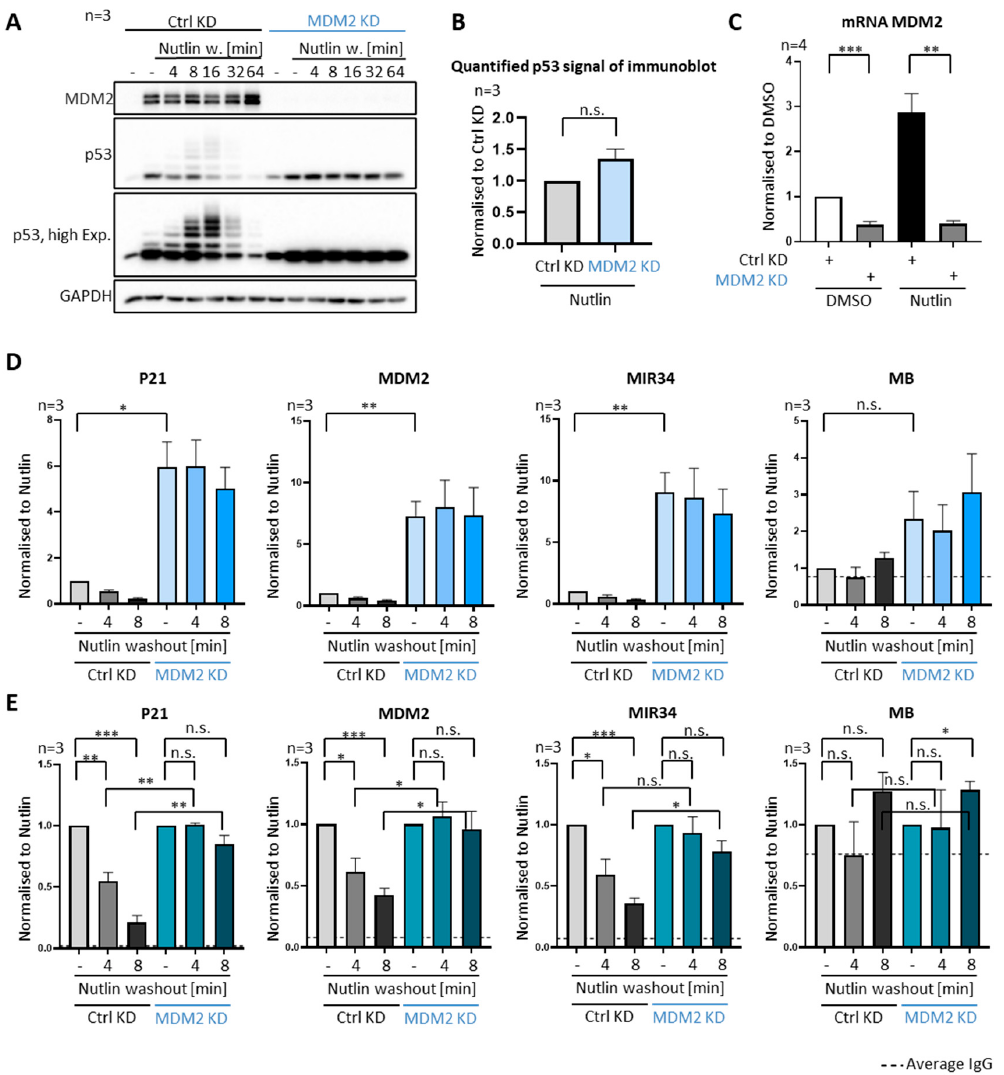
Figure 3. Requirement of MDM2 for removing p53 from promoters. ( A – E ) The Nutlin washout experiment was preceded by the depletion of MDM2 using siRNA transfection for 48 h, or by transfection of a scrambled negative control siRNA. ( A ) Knockdown (KD) of MDM2 largely abolished p53 ubiquitination and decelerated its degradation. ( B ) Quantification of the signal corresponding to p53 upon Nutlin treatment and either control KD or MDM2 KD in three biological replicates of immunoblot analyses, as shown in ( A ), lanes 2 and 8. Upon Nutlin treatment, p53 levels are hardly rising in cells transfected with siRNA to MDM2. ( C ) mRNA of MDM2 was measured by qPCR to confirm the depletion of MDM2 by siRNA transfection. ( D ) ChIP with anti-p53 antibodies after MDM2 depletion and Nutlin washout. P53 occupancy at its target genes P21, MDM2, MIR34 and MB (negative control) revealed increased p53 occupancy upon MDM2 depletion, and diminished removal of p53 upon Nutlin washout. Three biological replicates were normalized to chromatin input and then to the control transfected Nutlin sample (sample 1; without washout) and shown as mean + SEM. MDM2 depletion strongly increased the association of p53 with promoter DNA. ( E ) The same data as in ( D ) are now displayed with both Nutlin samples (samples 1 and 4; each prior to washout), regardless of the siRNA, set to 1 and used as normalization references for each siRNA species. This normalization allows a better comparison of both Nutlin washouts regarding their impact on the relative loss of p53 on promoters. Knockdown of MDM2 increased the stable association of p53 with its cognate promoter elements. *** p < 0.001; ** p < 0.01; * p < 0.05; n.s., non-significant. “-“, no Nutlin